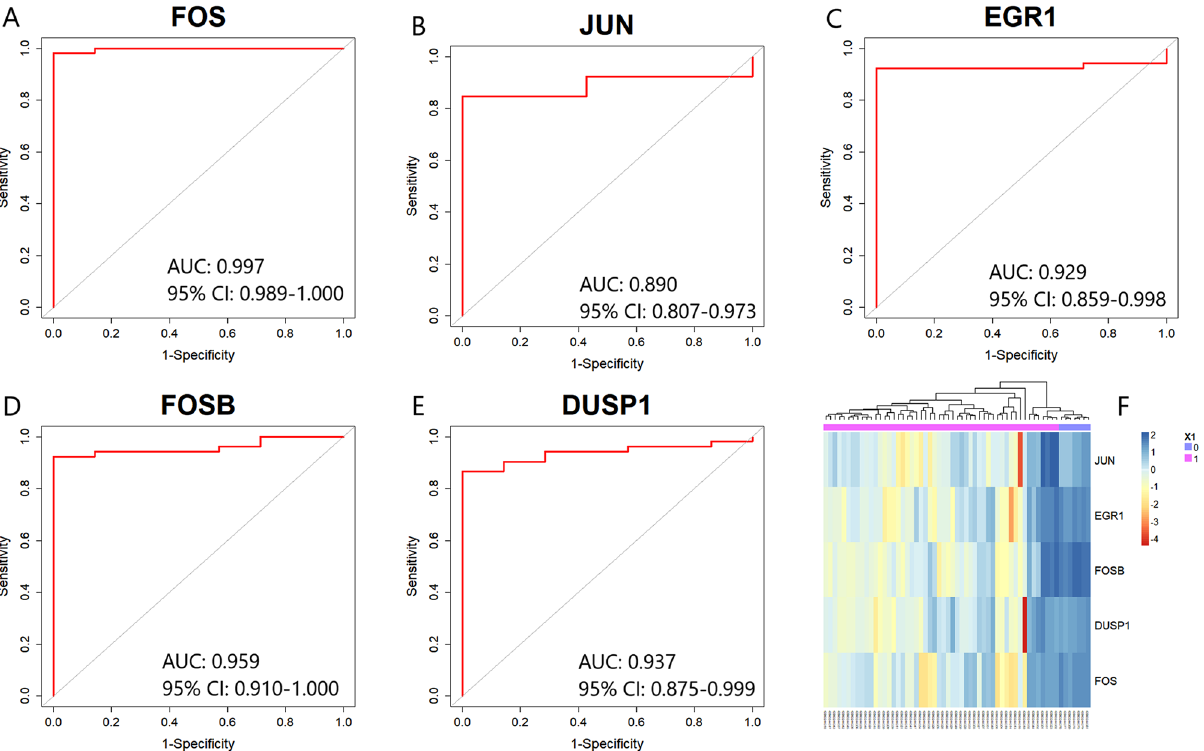
Figure 9. Validation of the five key candidate genes using ROC curves which were generated by pROC package with version 1.18.0 in R 29 (https:// cran.r- proje ct. org/ packa ge= pROC) and heatmap for GSE116626 dataset. ( A ) FOS ( B ) JUN ( C ), EGR1 ( D ) FOSB ( E ) DUSP1 ( F ) Heatmap of the five key candidate genes in renal tissue samples which were generated using “NMF” version 0.24.0 package in R 64 (https:// cran.r- proje ct. org/ packa ge= NMF). CI confidence